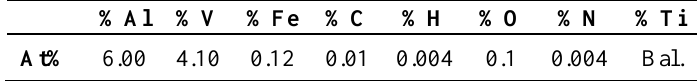
Table 1: Chemical composition of the Ti-6Al-4V alloy used